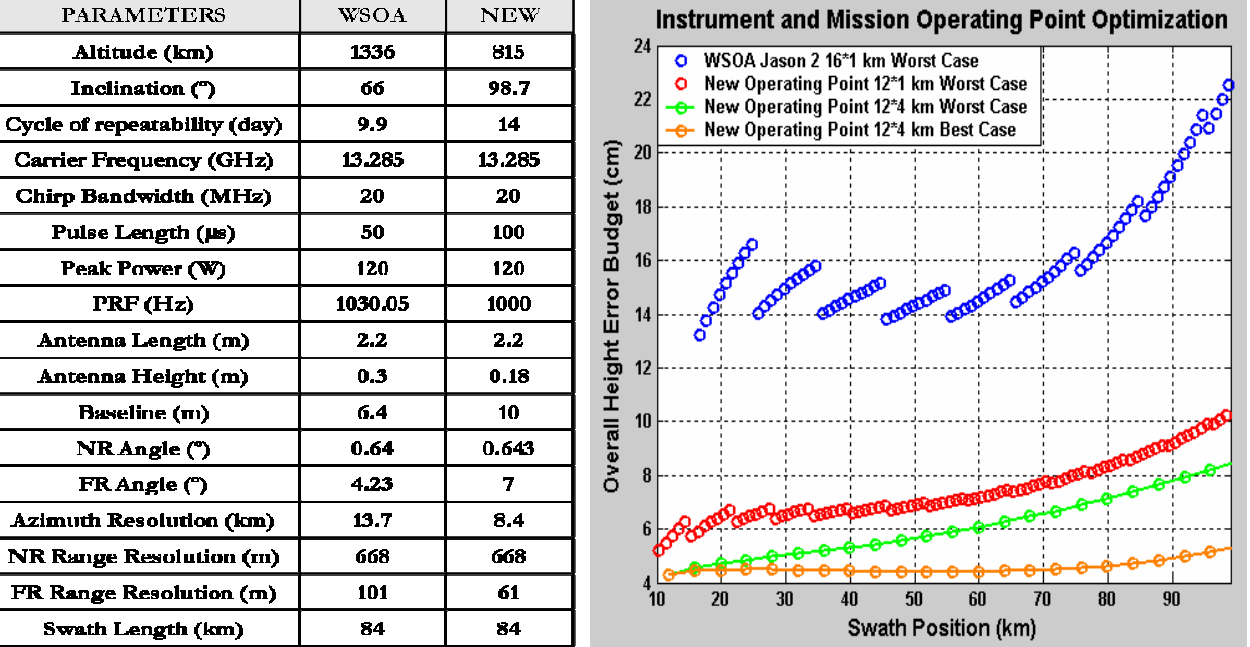
Figure 24. New operating characteristics for improving the height